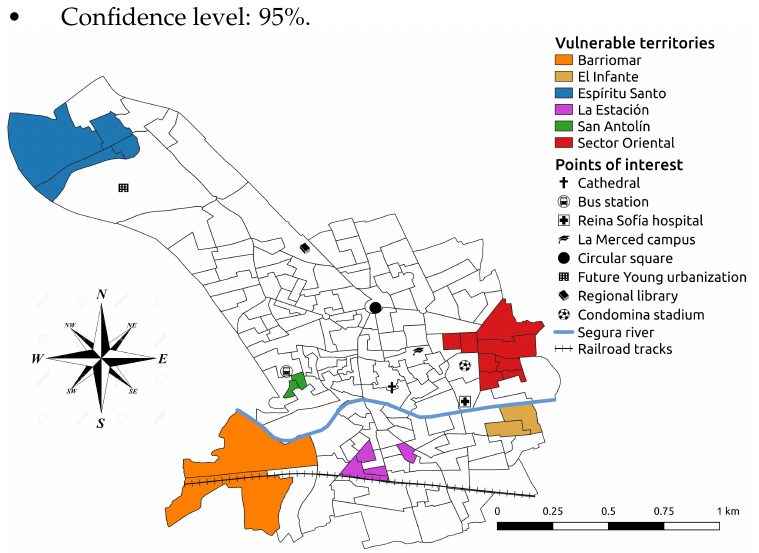
Figure 1. Vulnerable territories in the city of